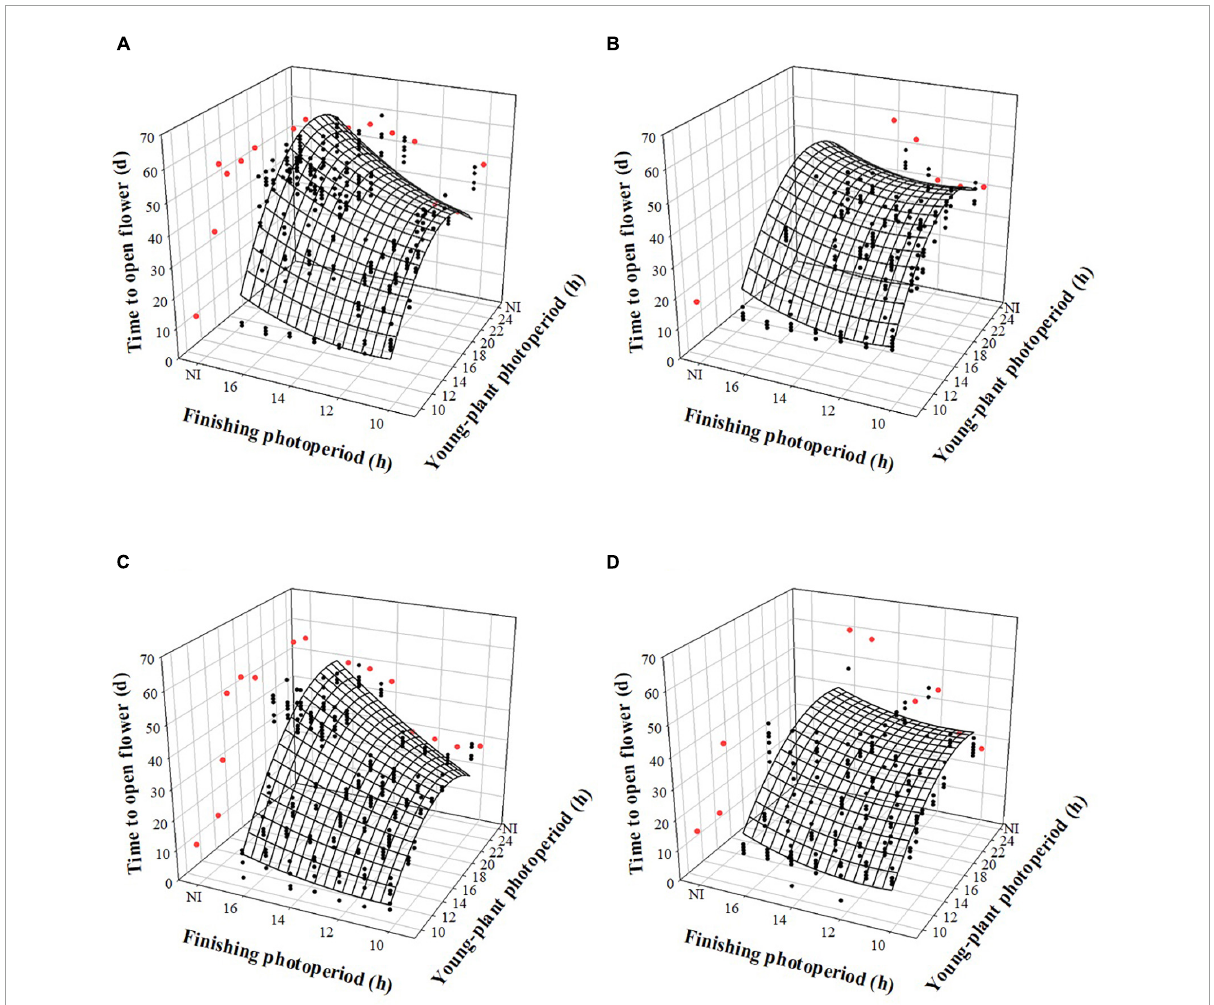
FIGURE4 Effects of young-plant photoperiod [9, 12, 13, 14, 16, 18, and 24 h, or a 4-h night interruption (NI)] and finishing photoperiod (10, 11, 12, 13, 14, 15, and 16 h, or a 4-h NI) on time to open flower of witchgrass ‘Frosted Explosion’ ( Panicum capillare ). Figures represent (A) moderate-DLI-grown ( ≈ 10 mol · m - 2 · d - 1 ) cut flowers from replication 1, (B) very-low-DLI-grown ( ≈ 3 mol · m - 2 · d - 1 ) cut flowers from replication 1, (C) moderate-DLI-grown cut flowers from replication 2, and (D) very-low-DLI-grown cut flowers from replication 2. Black circles represent individual data points for sequential photoperiods; red circles represent averages from NI treatments. Model predictions are represented by response surfaces; coefficients are presented in Table 8